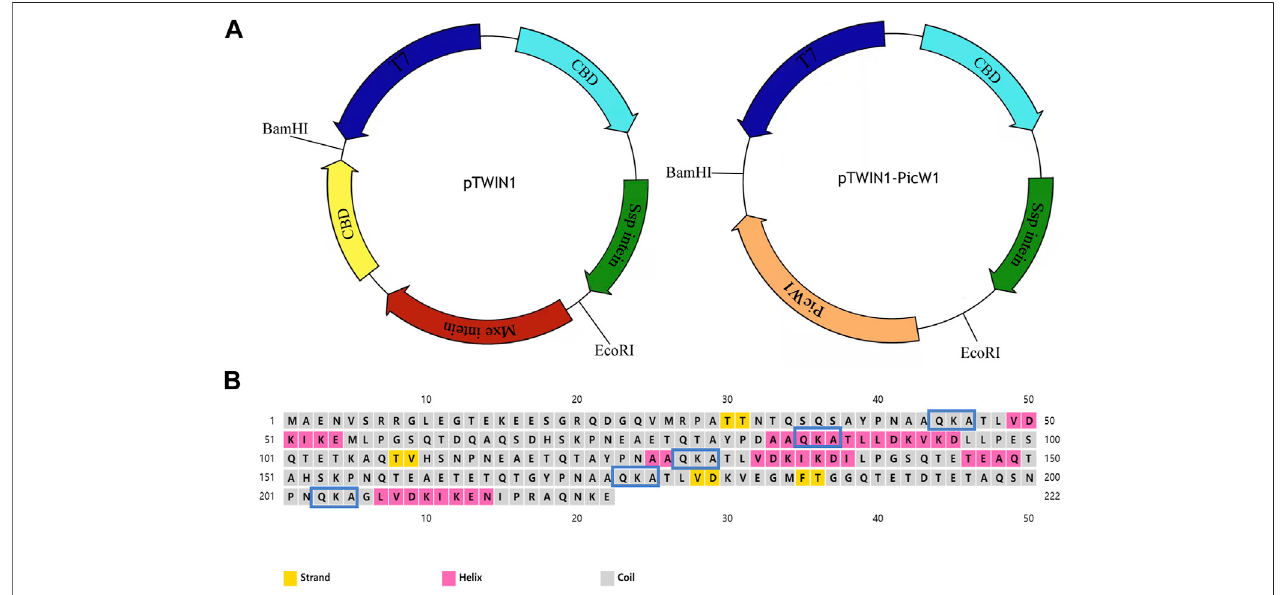
FIGURE 1 | Prokaryotic expression vector pTWIN1 and secondary structures of PicW1. (A) CBD, chitin-binding domain; Mxe intein, Mycobacterium xenopi GyrA intein; Ssp intein, Synechocystis sp. DnaB intein gene; PicW1, the coding region of PicW1 gene; T7, T7promoter. (B) PicW1 has 222 amino acids, of which 5 K- segments start from the amino acid sequence QKA. Yellow squares represent the strand, pink squares represent the helix, and gray squares represent the coil.